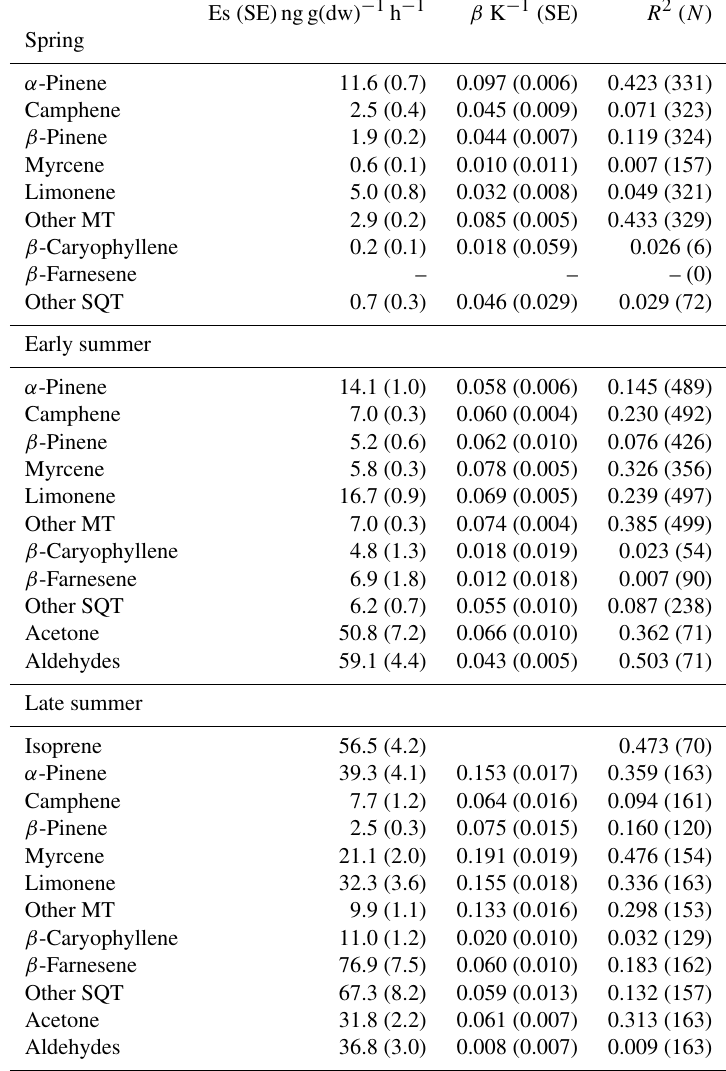
Table 5. Standard (30 ◦ C) MT, SQT, acetone, and C 4 –C 10 aldehyde emission potentials obtained in 2011, 2014, and 2015. For isoprene the β coefficient are given with the standard error of the estimate (SE, in parentheses). R squared and the number of measurements ( N ,